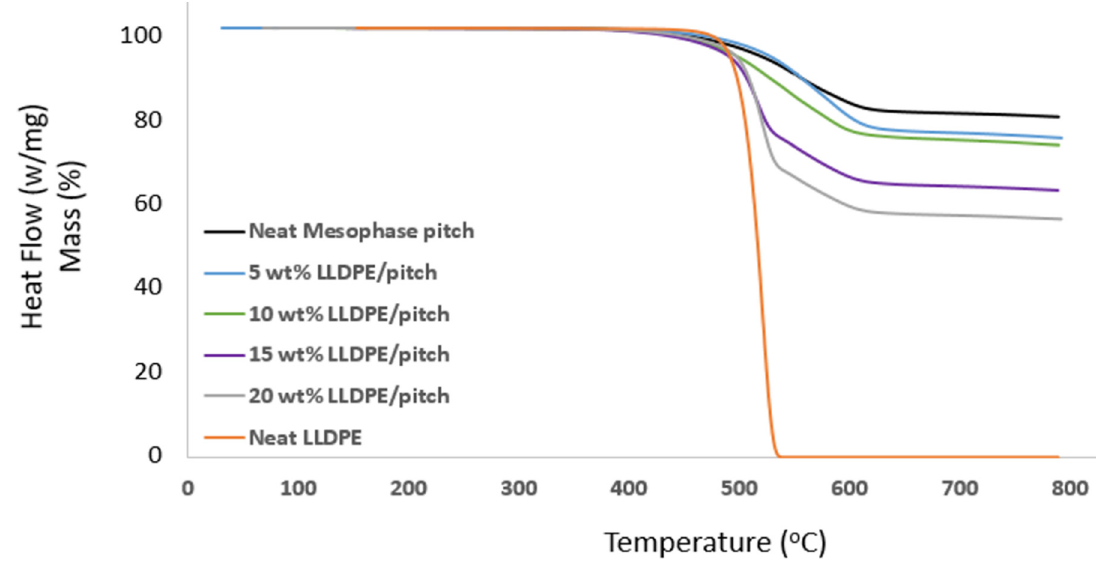
Figure 7. TGA curves of various proportions of LLDPE in LLDPE/mesophase pitch blends .